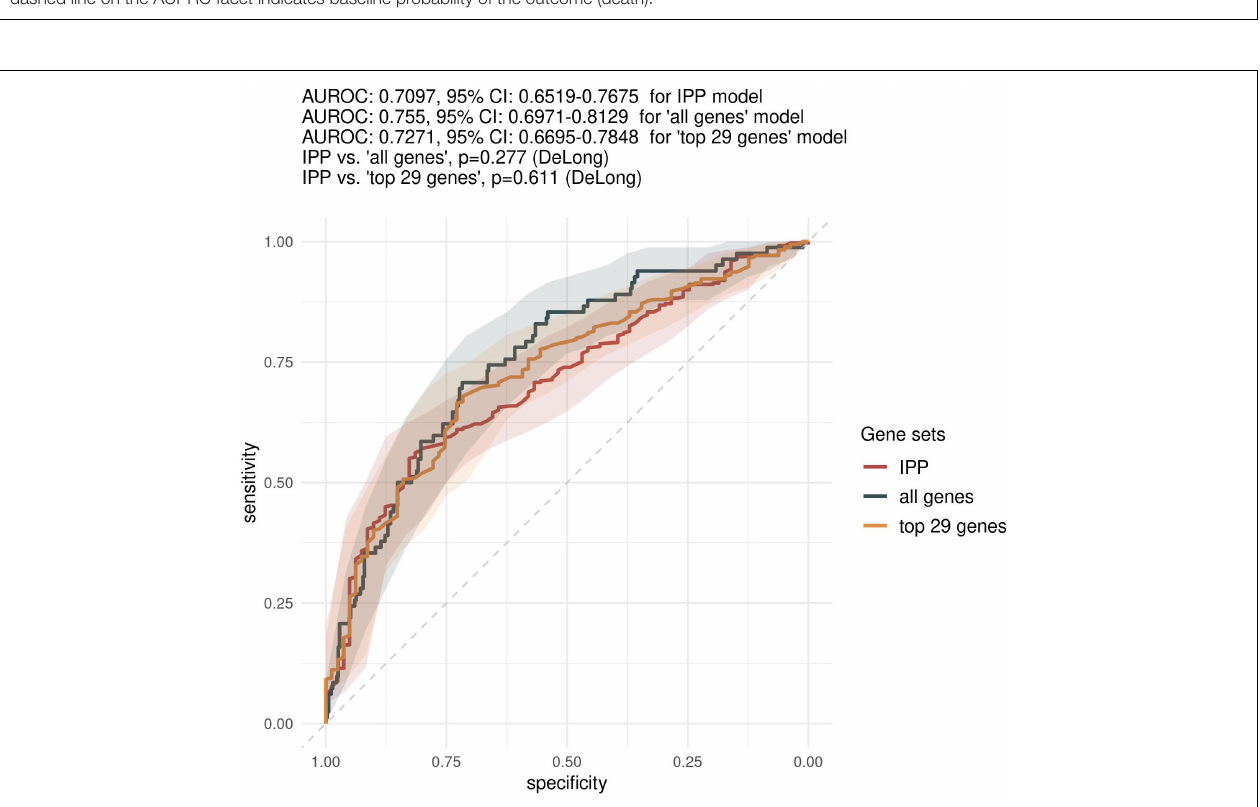
FIGURE 3 | Comparison of predictive performances of the IPP gene set with that obtained with other genes on the “day 1” data set. We compared the predictive performance of the IPP gene set to that obtained with other genes common to the 17 microarray studies by computing ROC curves obtained by prediction on the validation set with IPP, “all genes” and “top 29 genes” models trained on GE data collected at day 1 following admission. Gray areas indicate 95% confidence intervals of corresponding AUROCs.